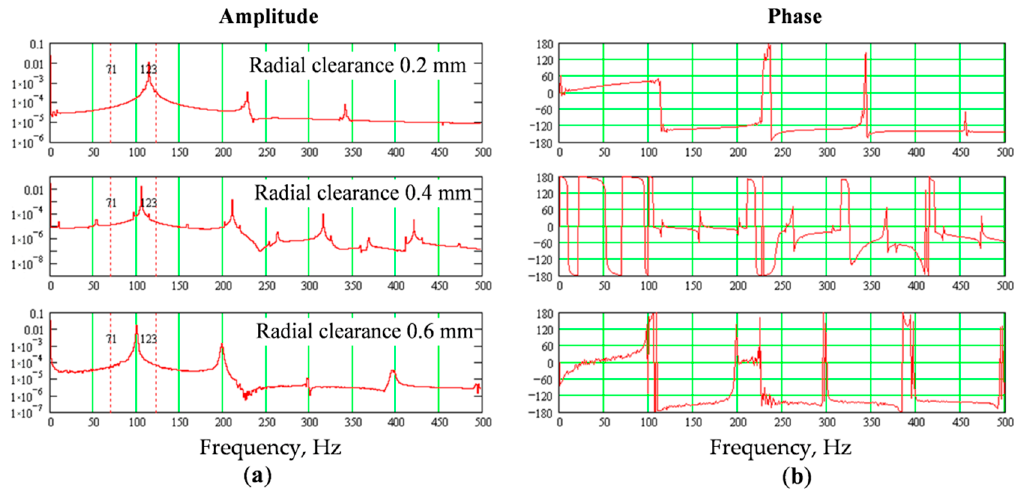
Figure 7. Amplitude ( a ) and phase ( b ) plots of shaft vibrations depending on the wear (radial clearance) in the bearing support without opening the bolted joints. Table 2. Results of vibration measurements (Figure 8).